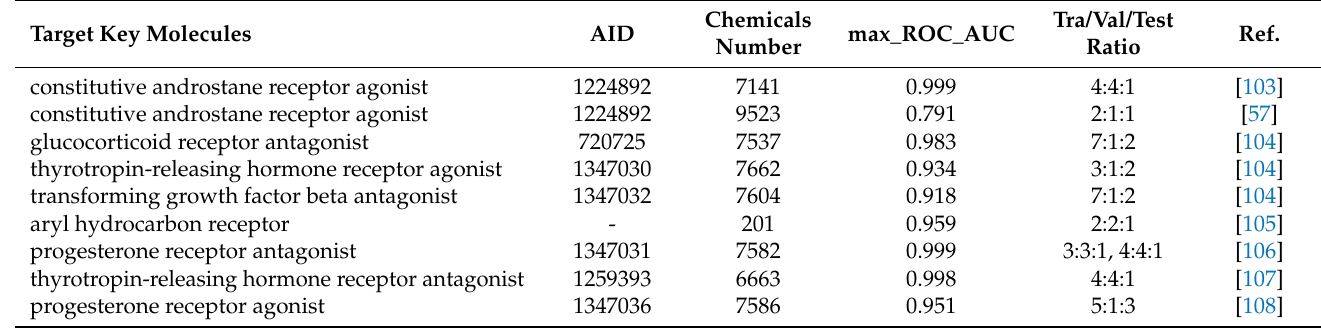
Table 2. Prediction Models Constructed using Deep Snap–Deep Learning